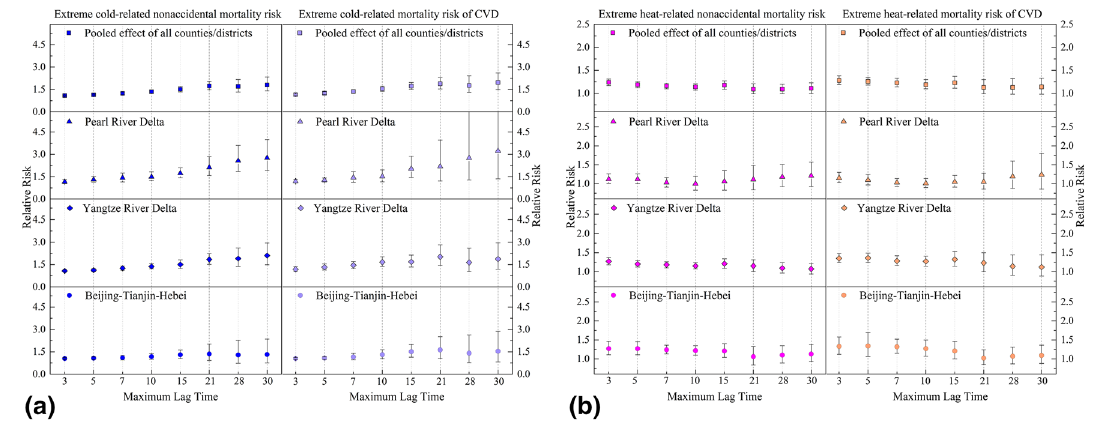
Fig. 2 Sensitivity analysis of extreme cold/heat-related mortality risks with confidence intervals of different maximum lag time in three city clusters in eastern China. a Lag effect of extreme cold-related mortality risk. b Lag effect of extreme heat-related